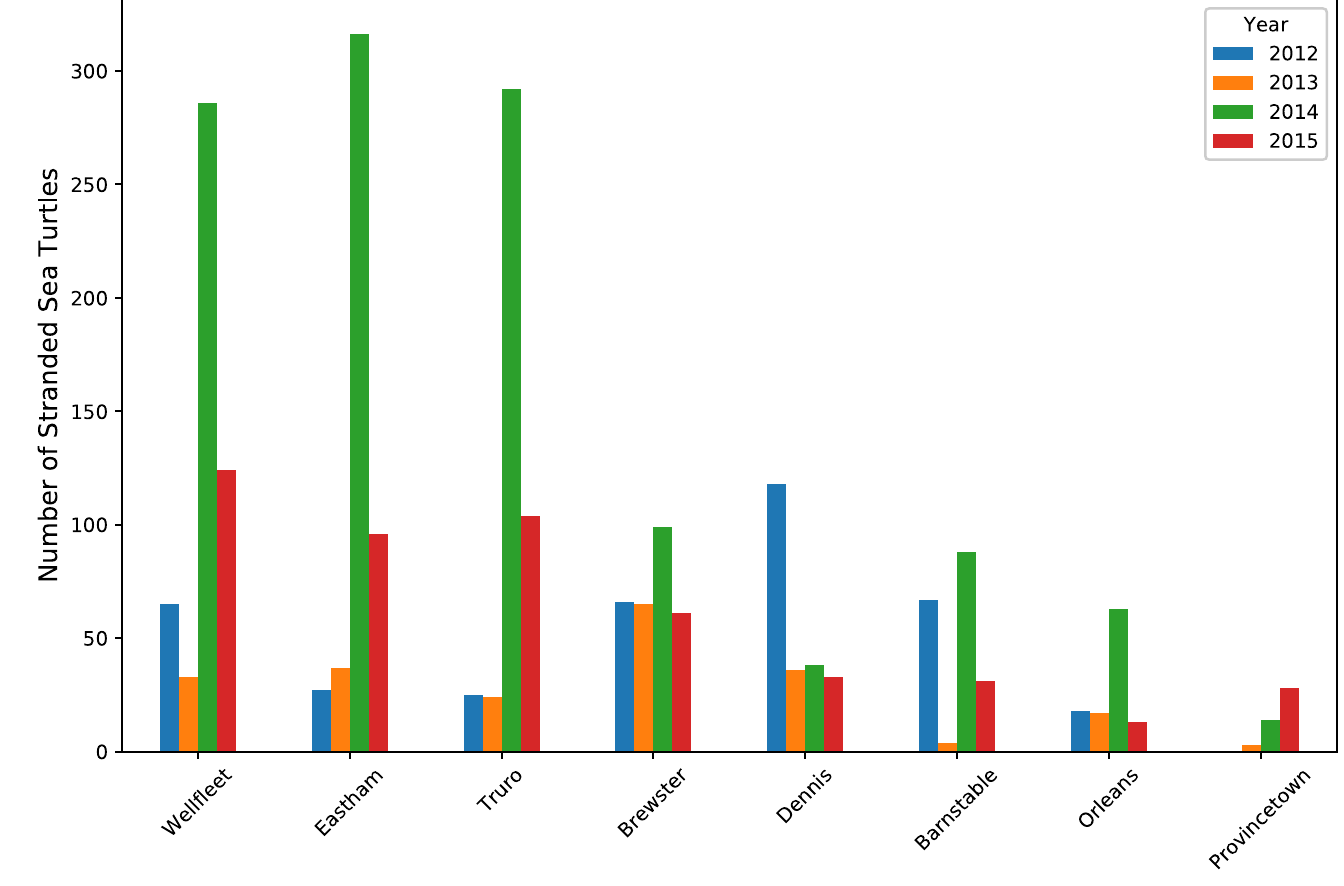
Fig 5. Chart of the number of strandings by town between 2012–2015 showing most in the first three Outer Cape towns.